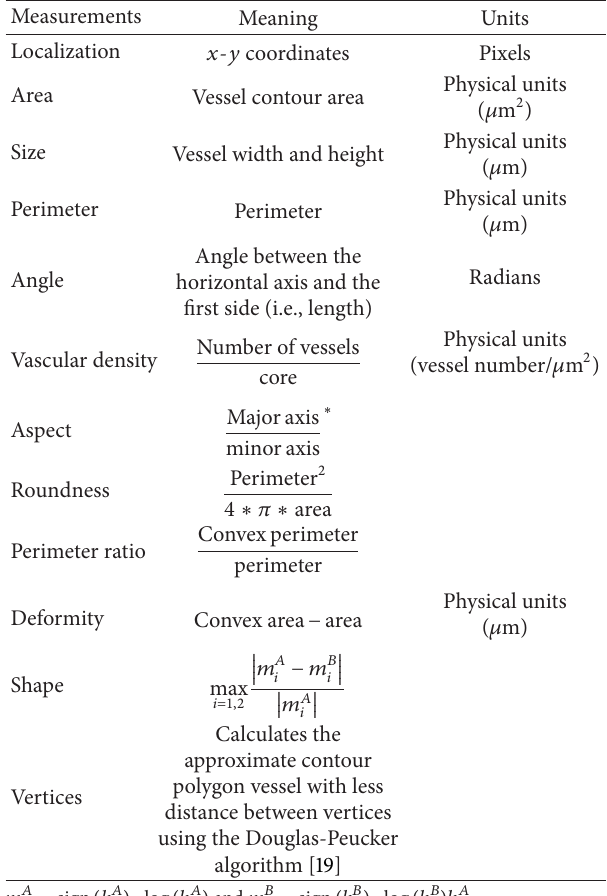
Table 1: Morphometric